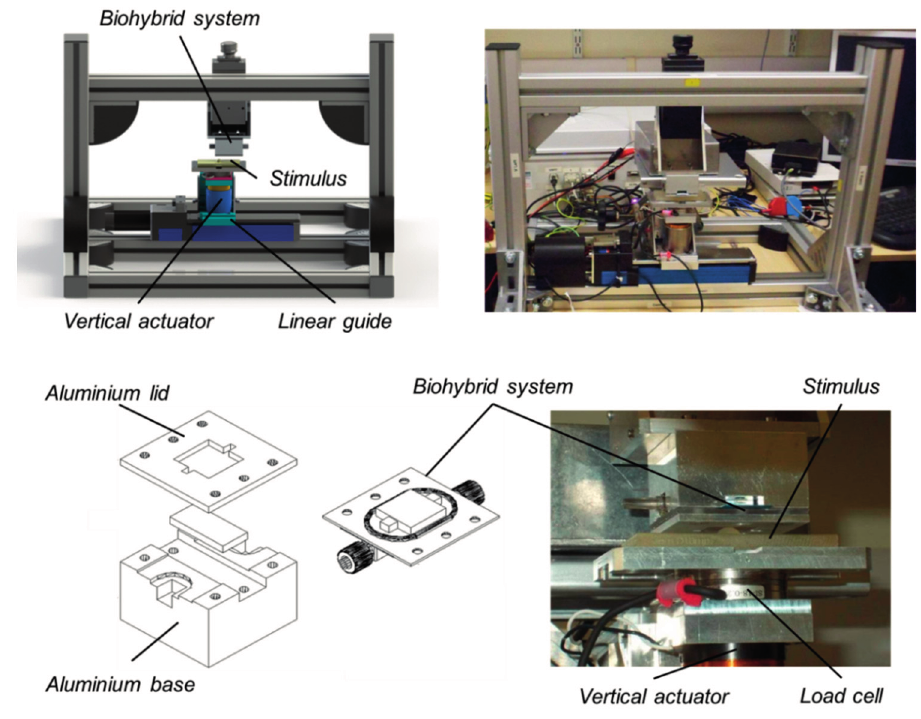
Figure 6. Integration of the bio-hybrid sensor in the dynamic tactile stimulation platform: Concept design and experimental